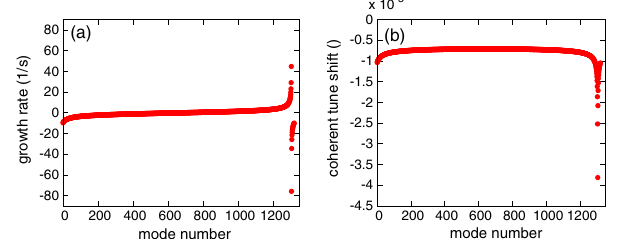
FIG. 2. Complex frequency shift for the uniform filling pattern with M ¼ h ¼ 1320 at instability threshold I U growth rate (a); coherent tune shift (b). The fastest unstable mode μ ¼ 1303 has growth rate τ − 1 μ ¼ 1 = τ vertical radiation damping